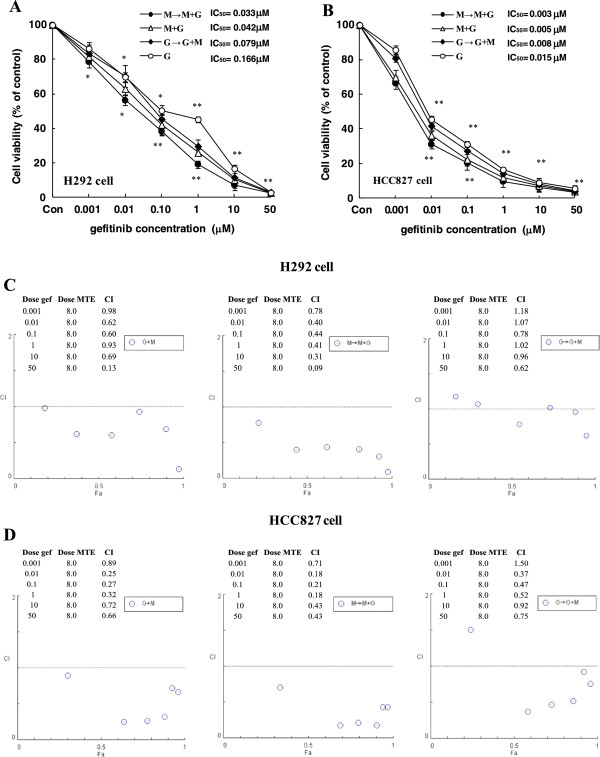
MTE (M. tenacissima extract) enhances gefitinib induced cytotoxicity in gefitinib-sensitive non-small cell lung cancer cell lines. H292 (A) or HCC827 (B) cells were incubated with increasing concentrations of gefitinib and MTE alone or different schedule combinations. Treatment schedule: (1) M → M + G, MTE pretreated for 12 h, then M + G (MTE + gefitinib) for another 72 h. (2) M + G, MTE and gefitinib concomitantly treated for 72 h. (3) G → G + M, gefitinib pretreated for 12 h, then G + M (gefitinib + MTE) for another 72 h. Growth assays were performed by MTT assay and IC50 values were calculated by Graphpad Prism 5.0 software (San Diego, CA, USA). CI values for the combinations of gefitinib and MTE in H292 (C) and HCC827 (D) cells were calculated using the Calcusyn software (Cambridge, UK), as described in the Methods section. Each data point represented the mean of 3 to 4 replicates; r values for all curves were >0.95. *P < 0.05, **P < 0.01 vs. control group.